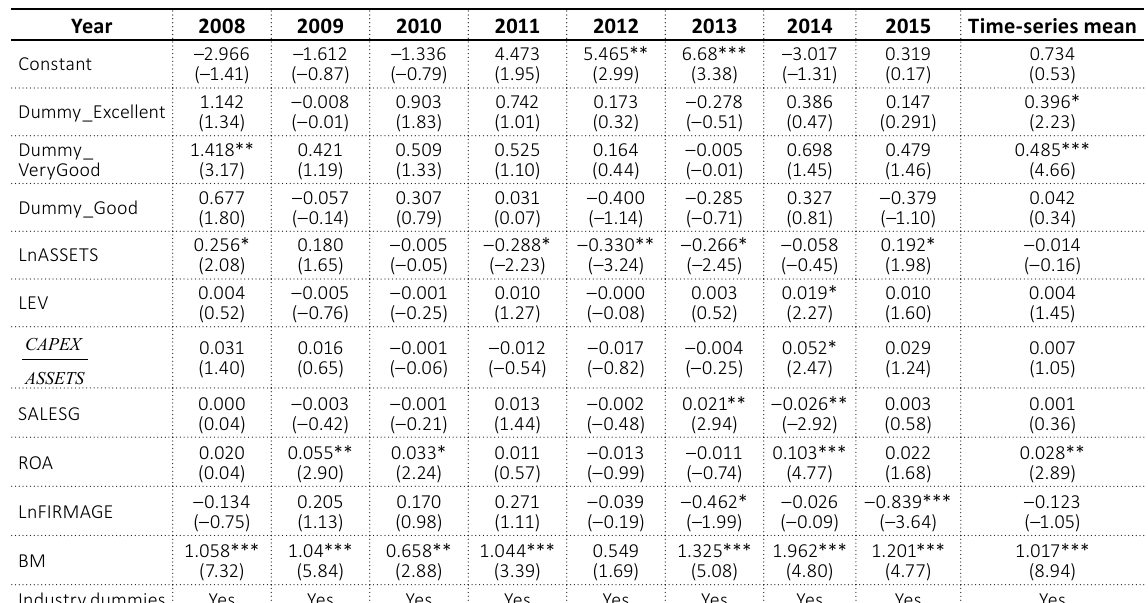
Table 3. Corporate governance by dummy variable and stock returns with industry